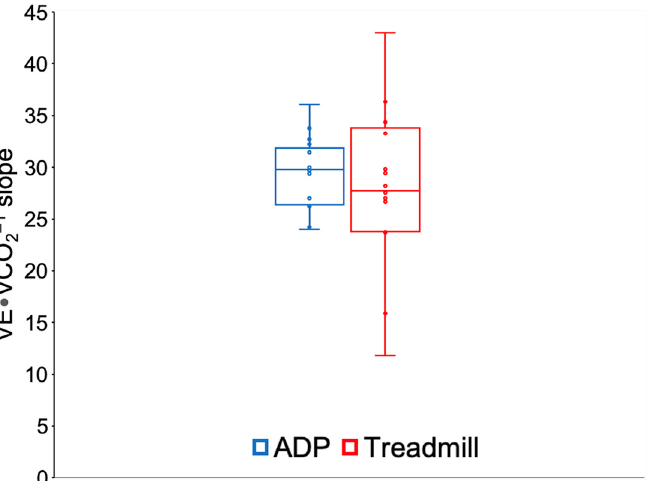
Figure 2. Ventilatory efficiency (VE · VCO 2 − 1 slope) during aerobic dance (AD) exercise on an air dissipation platform (ADP) and constant-load treadmill test at VT1